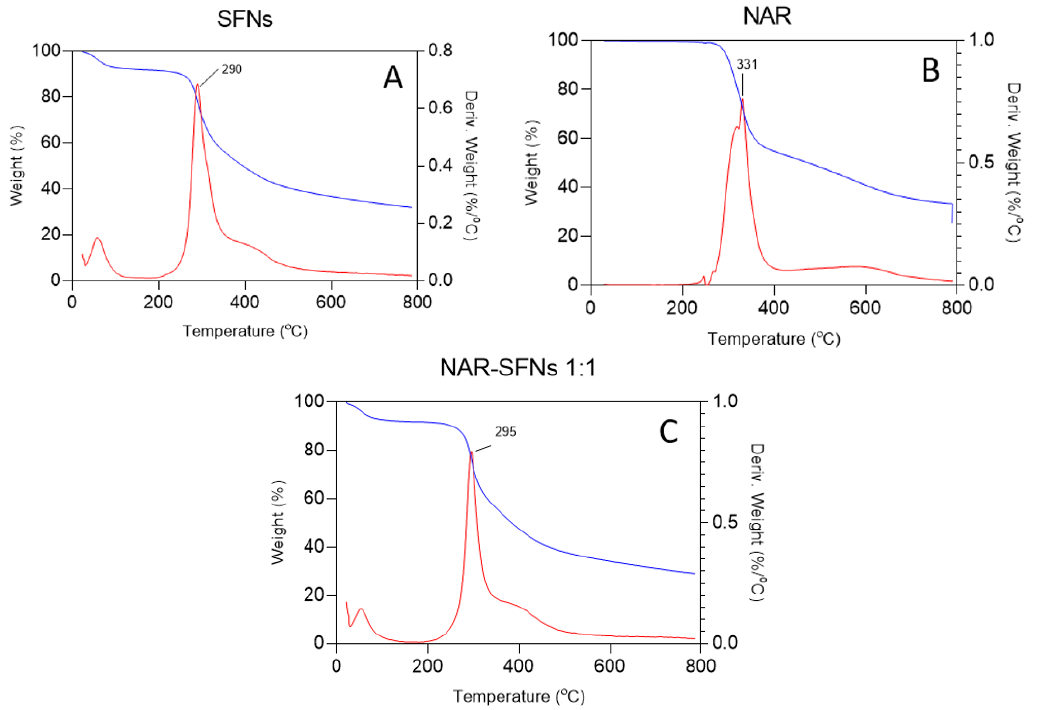
Figure 4. Thermogravimetrical analysis (TGA) and first derivative of the TGA (DTGA) of the ( A ) SFNs, ( B ) NAR and ( C ) NAR-SFNs 1:1.